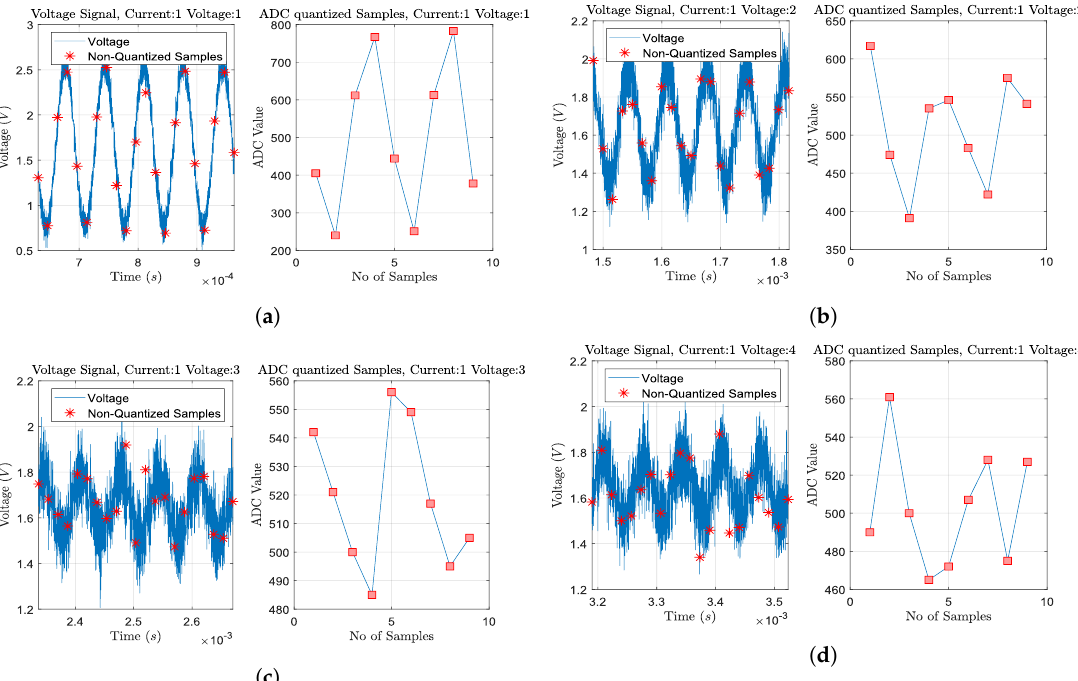
Figure 8. Transient plus noise simulations and ADC sampling process for some particular voltage channel measurements, when at deflated state, acting at 15 kHz, 2 mA p − p current signal, and considering 0.05 radius passive electrodes without position deviation. Sampling and quantization is performed for 2 sine periods, as shown in each right part. Current is injected from the 1st and the 2nd electrodes (adjacent current protocol). The ADC resolution is considered at 12-bit (10-bit ENOB) with a 3.3 V reference voltage. ( a ) Adjacent voltage measuring between the 3rd and the 4th electrodes. ( b ) Adjacent voltage measuring between the 4th and the 5th electrodes. ( c ) Adjacent voltage measuring between the 5th and the 6th electrodes. ( d ) Adjacent voltage measuring between the 6th and the 7th electrodes. As the voltage measuring electrode pair becomes far from the current injecting pair, the noise effect becomes more significant, due to the signal’s amplitude